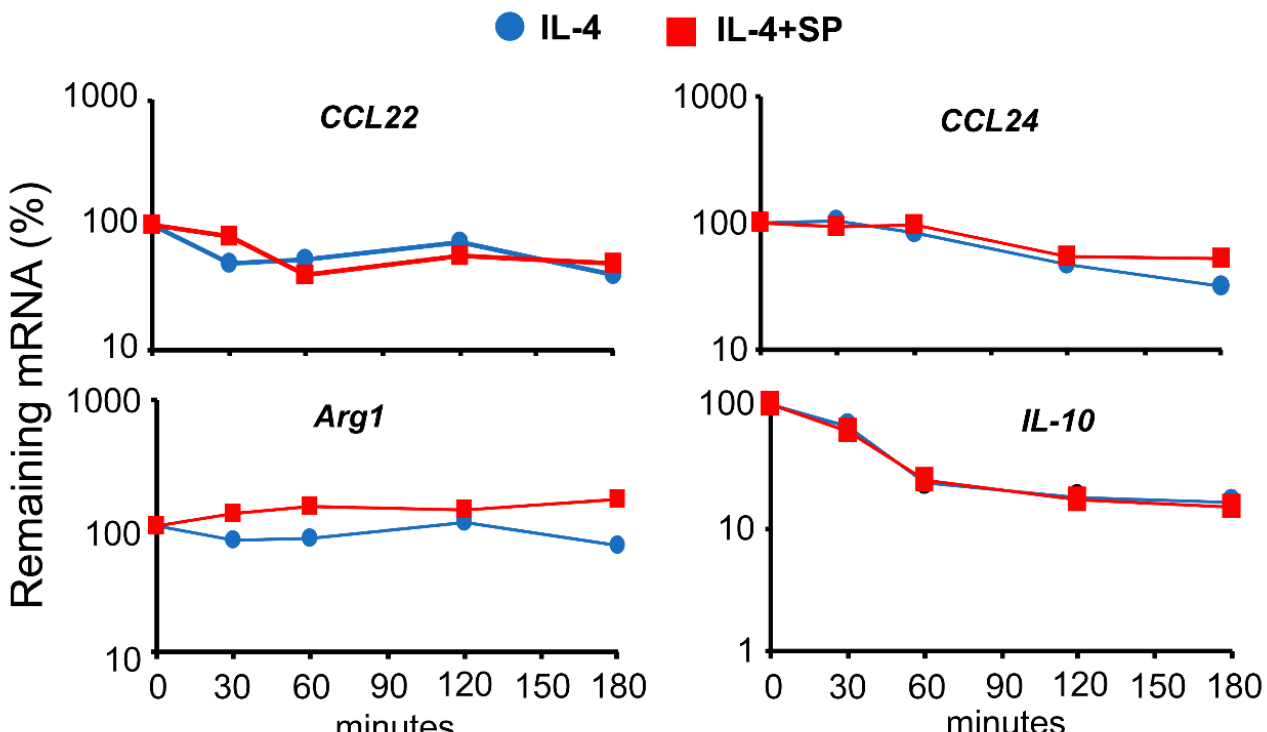
Figure 5. Effects of JNK-1 on the mRNA stability of IL-4-induced genes. Macrophages were pre- incubated with SP600125 for 1 h; then, IL-4 was added, and incubation proceeded for 6 h. At this point, a combination of the RNA synthesis inhibitors 5,6-dichlorobenzimidazole 1- β -D-ribofuranoside (DRB) (20 µ g/mL) and actinomycin D (Act D) (5 µ g/mL) was added for the indicated periods of time. The levels of gene expression were evaluated using qPCR. To evaluate the rate of mRNA degradation, the mRNA remaining after treatment with inhibitors of RNA synthesis was calculated as a percentage of the expression of the gene in the cells stimulated with IL-4 (+/ − SP600125) in the absence of RNA synthesis inhibitors. These experiments were performed three times, and the results from the mean are shown. Data were analyzed using Student’s t -test, and no significant differences were found.